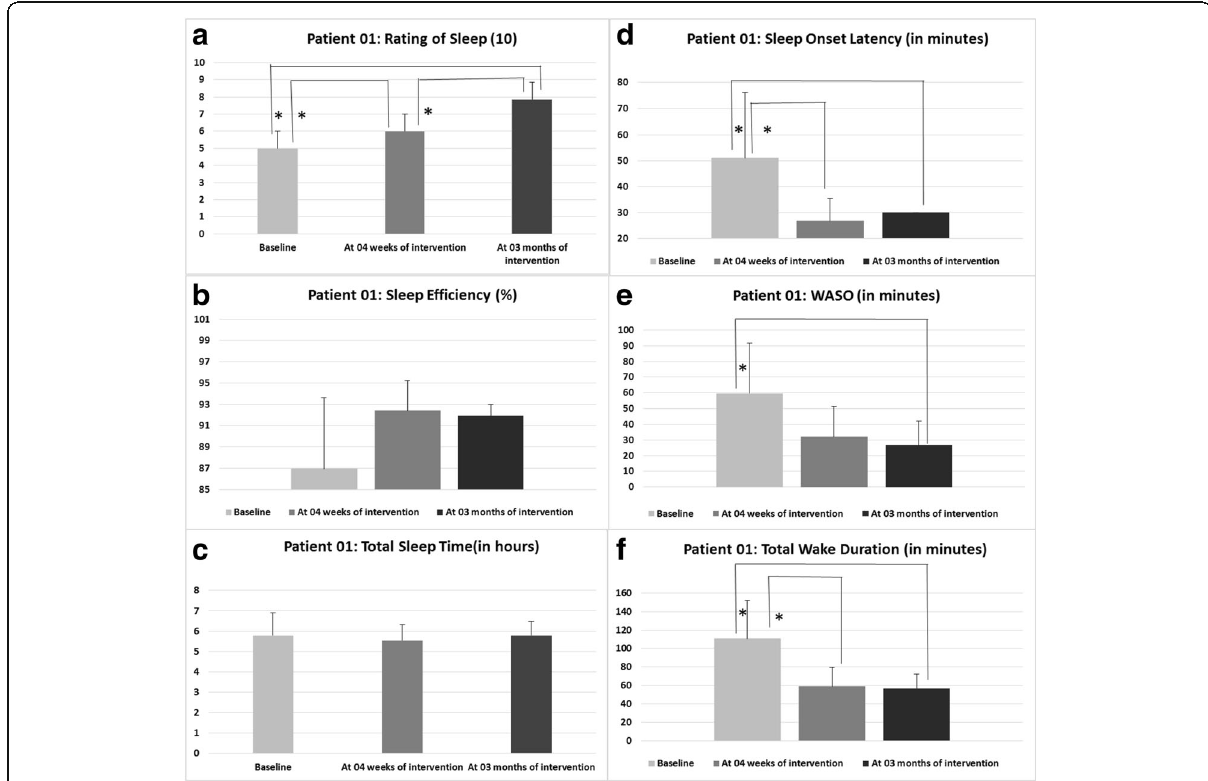
Fig. 3 a – f Sleep diary parameters of patient 01 showing various sleep wake parameters. * p < 0.025(using Wilcoxon Signed Rank test and adjusted Bonferroni correction p < 0.05/2 =